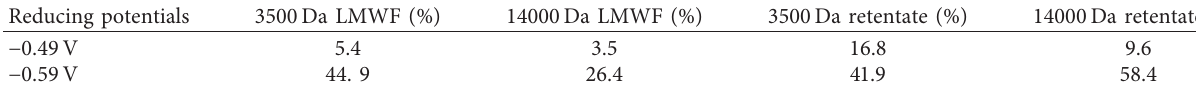
Table 2: The proportions of EEC of PPNOM and LNOM.